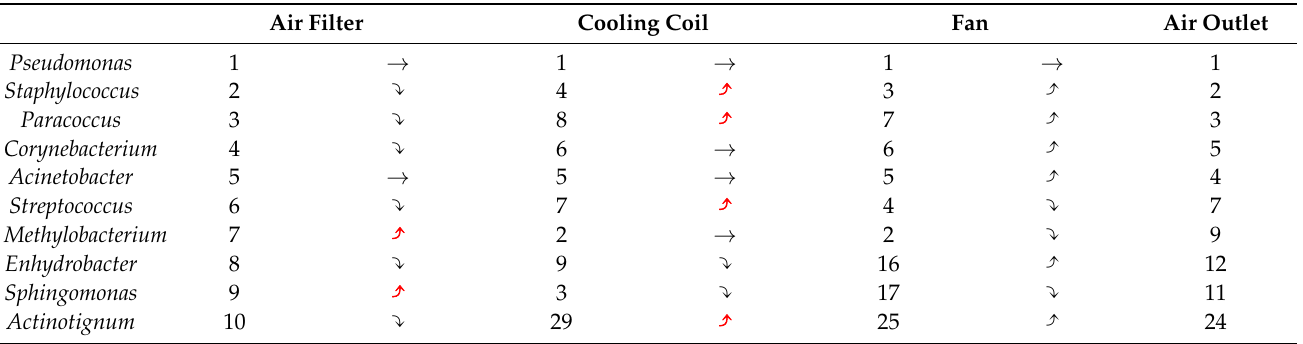
Table 2. Change in the ranking of the relative abundances of the top 10 air-filter-adherent bacteria.